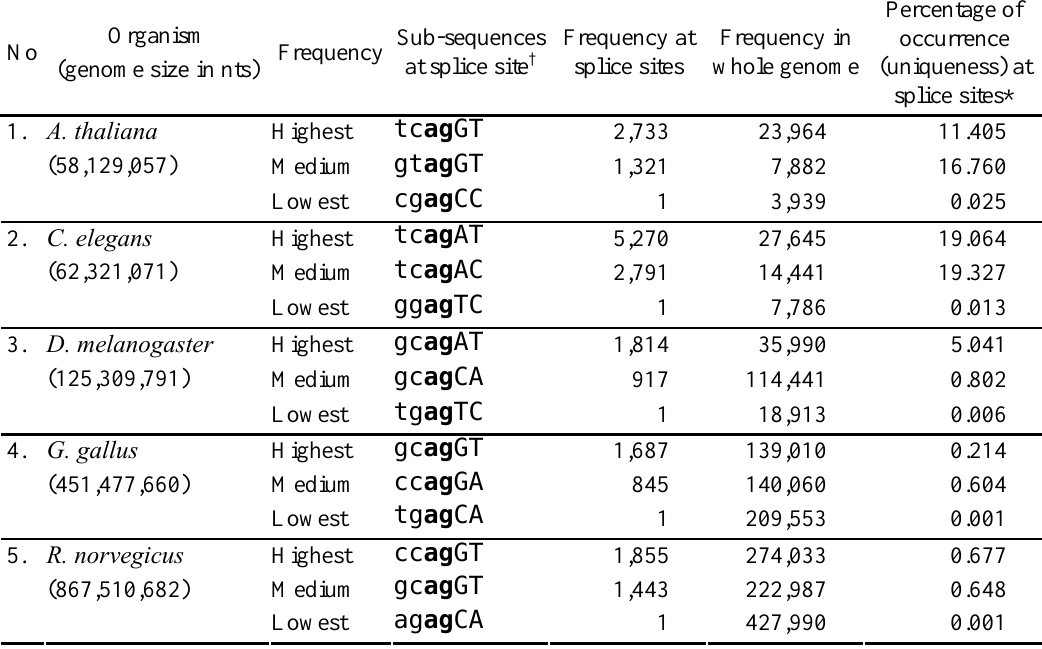
*The percentage of occurrence (uniqueness) values is normalized to three decimal points in order to represent even the lowest values. † The two central, highly conserved dinucleotides in the sub-sequences are shown in bold.